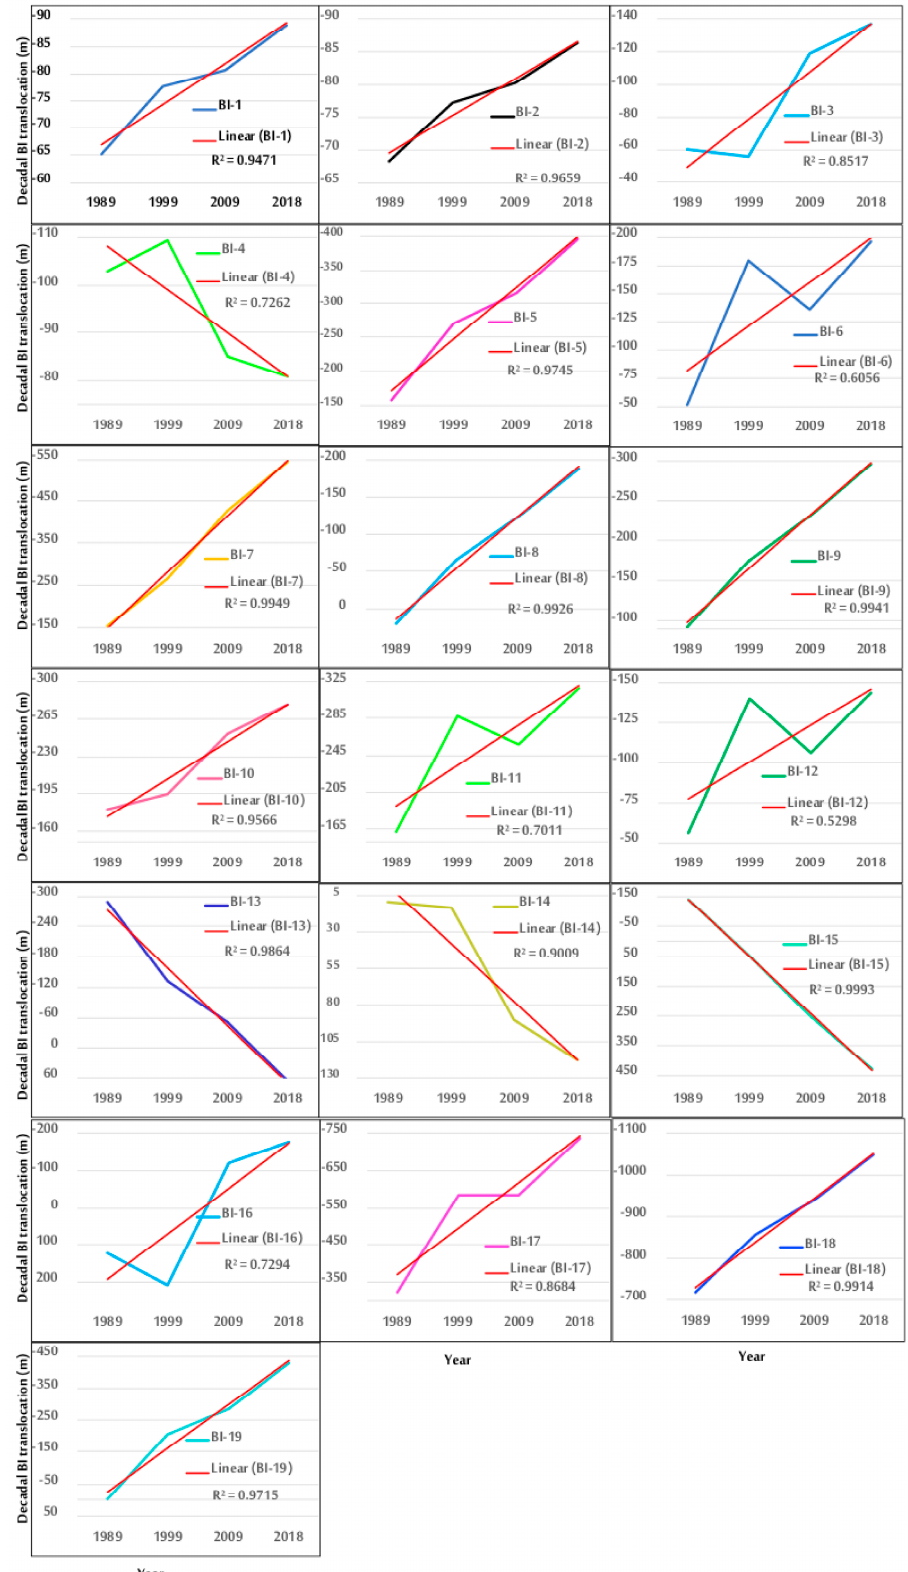
Figure 8. Historical trend of migration/erosion of barrier islands along study area shoreline, from 1989 reference shoreline derived using a transect based